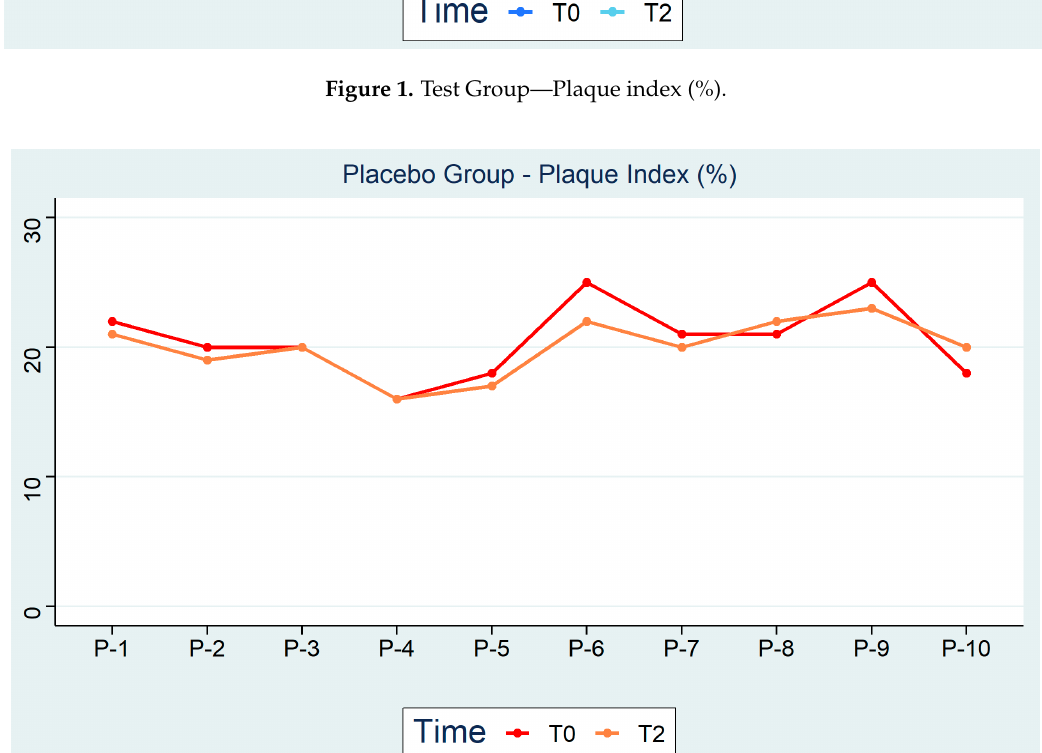
Figure 2. Placebo Group—Plaque index (%).